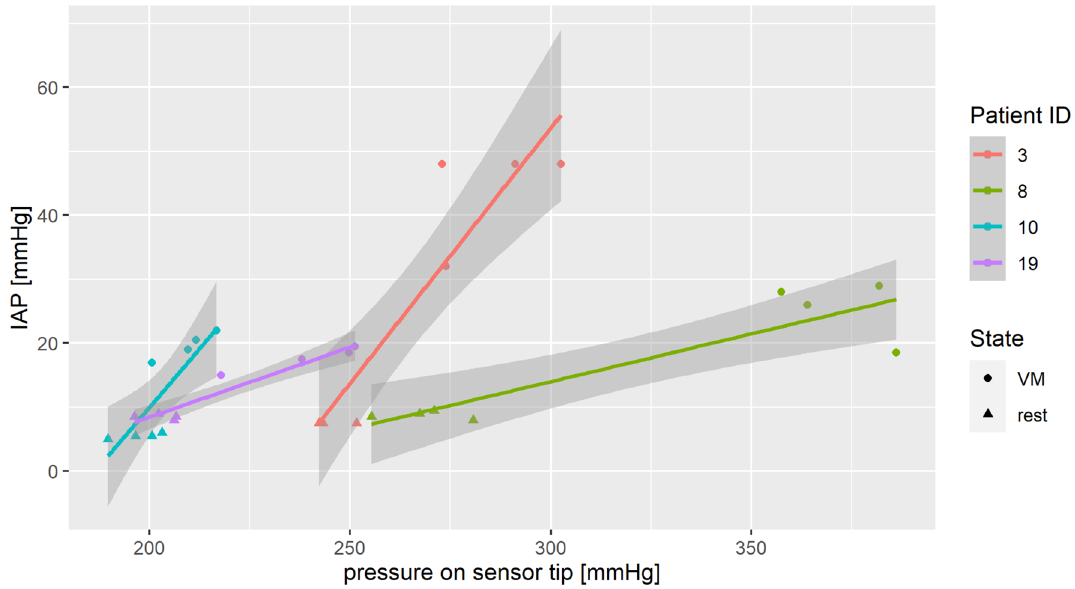
Figure 3. Intravesical and calibrated MC measurements of pressure in selected patients. Note: the MC values show the raw values of pressure on the sensor tip and have not yet been modelled to estimate the IAP.